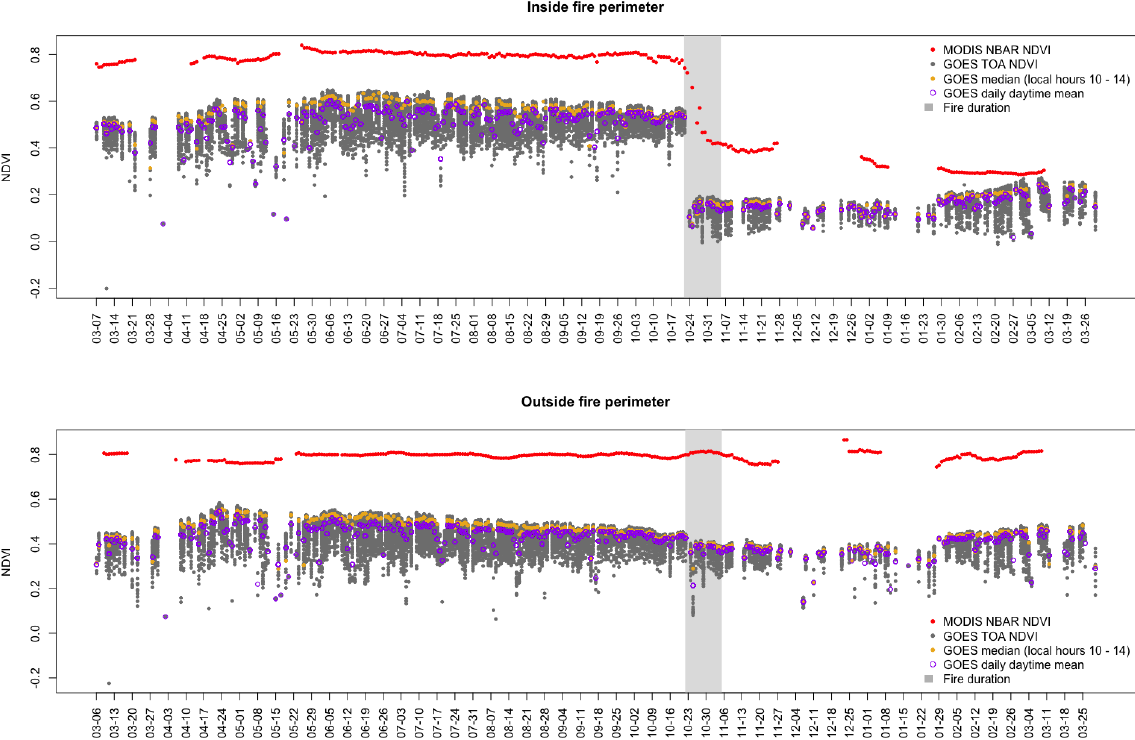
Figure 3. Normalized difference vegetation index (NDVI) calculated using TOA reflectance factor from ABI on GOES-16 and Nadir Bidi- rectional Reflectance Distribution Function-Adjusted Reflectance (NBAR) from MODIS on the Terra and Aqua satellites for pixels inside and outside the Kincade fire (23 October 2019) perimeter in northern California for the period March 2019 to March 2020. The GOES Clear Sky Mask algorithm was applied to observations from GOES. MODIS NBAR with good quality flags were used. All observations are daytime, with a solar zenith angle of < 70 ◦ . The locations of the points inside and outside of the fire perimeter are displayed in Fig.